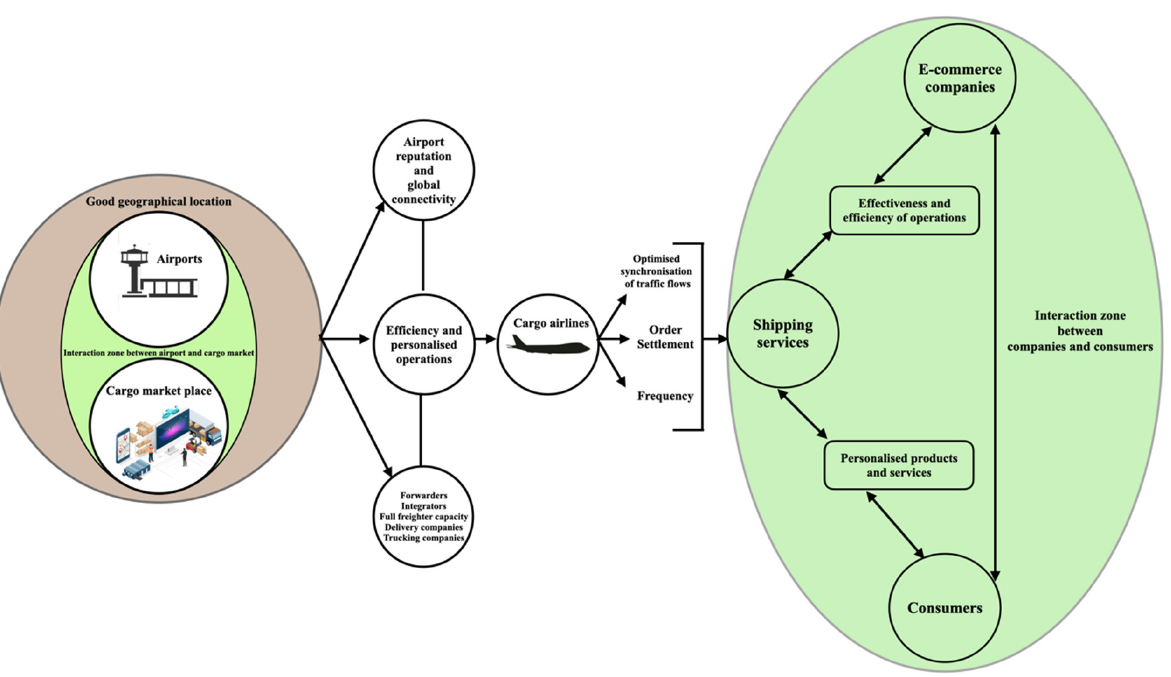
Figure 11. Overall research model. Source: Author’s own elaboration. Shopping and returns by companies or consumers.